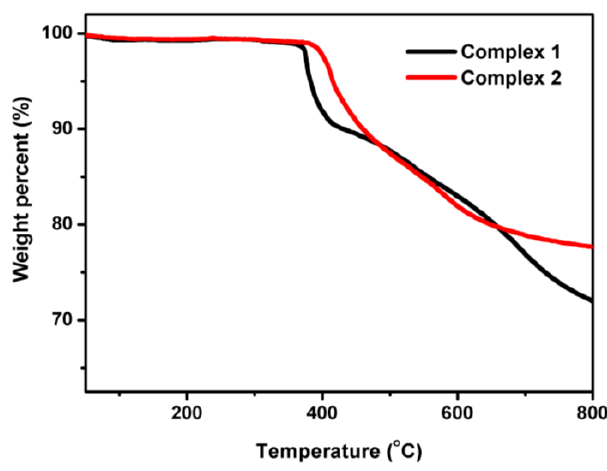
Figure 6. Thermogravimetric analysis (TGA) curves of complexes 1 and 2 .